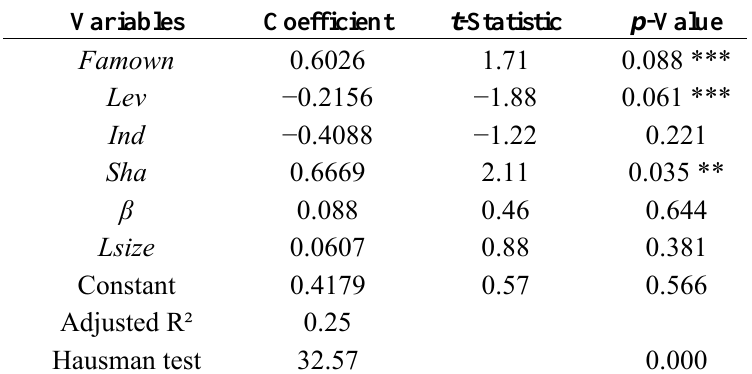
Table 3. Results of estimation based on complete